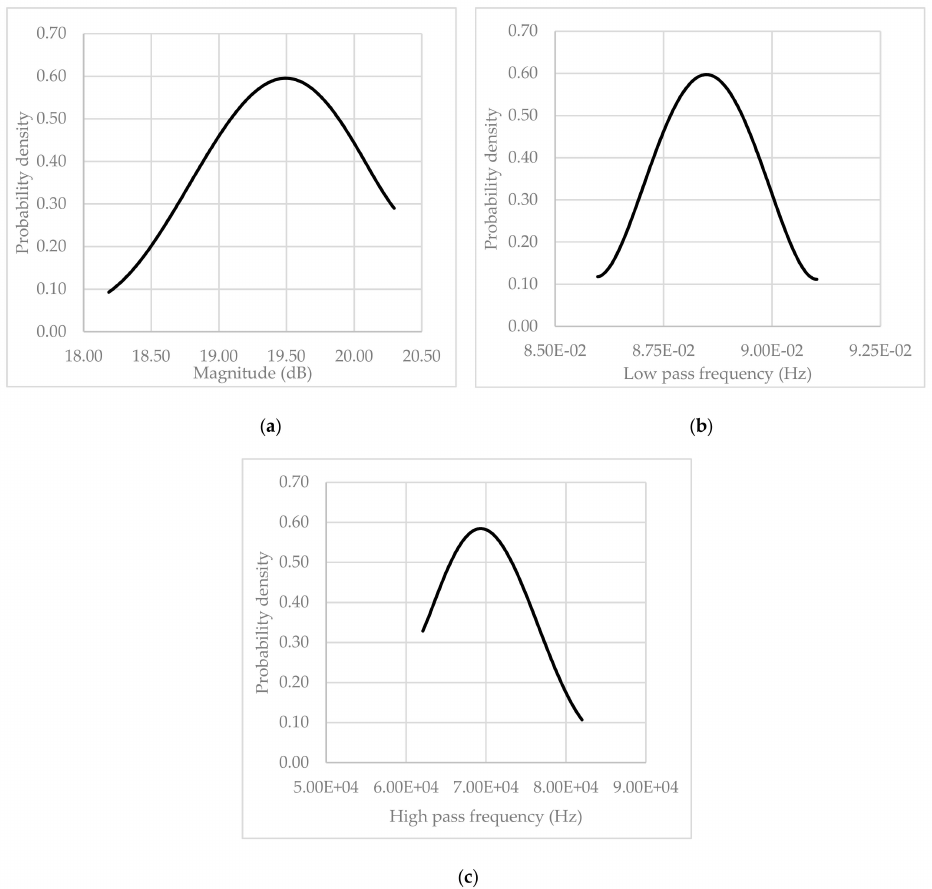
Figure 12. Statistical distribution of ( a ) the output voltage, ( b ) the lower cuto ff frequency, ( c ) the higher cuto ff frequency, evaluated under random PVT